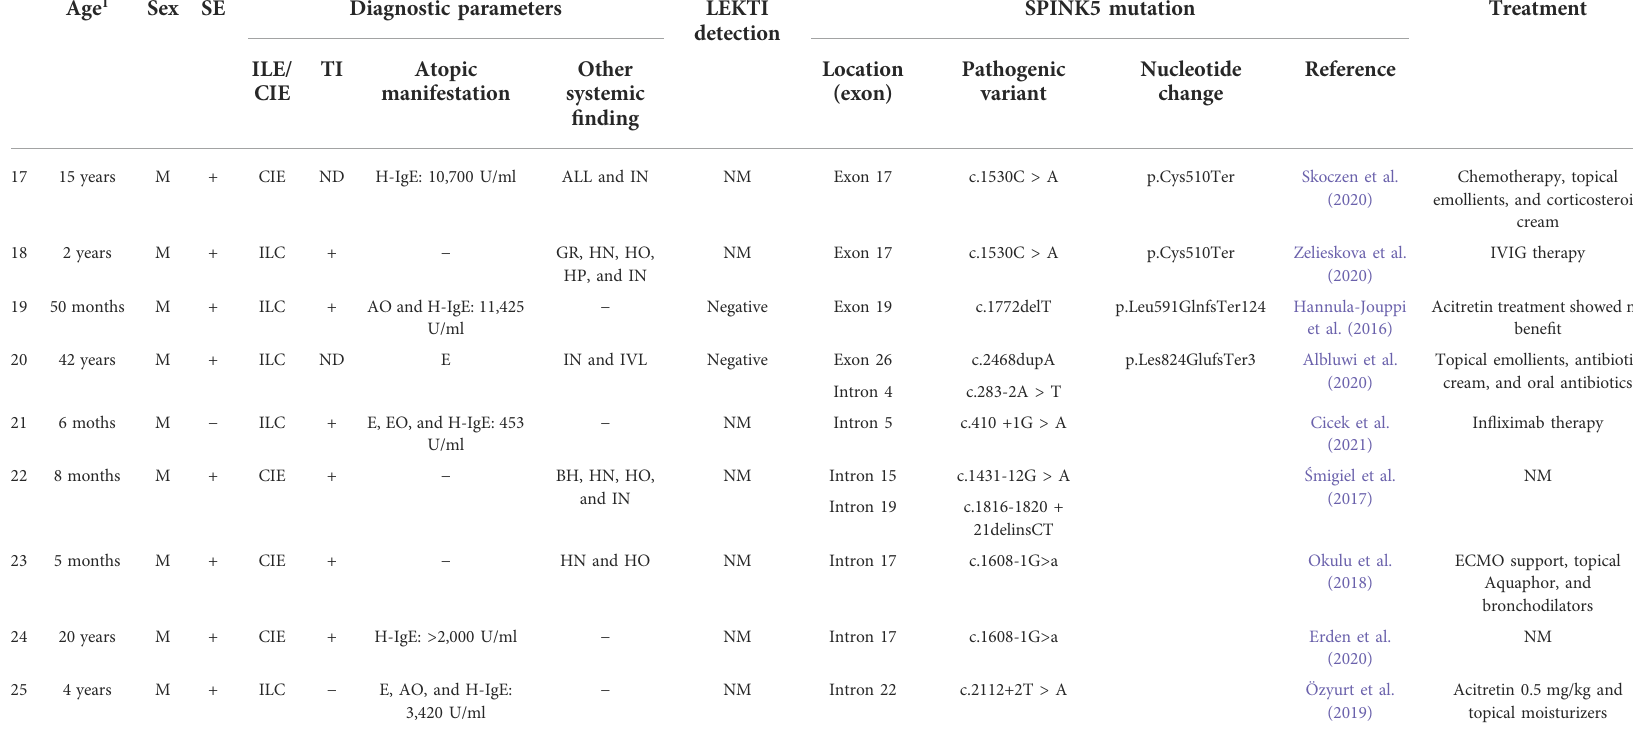
TABLE 1 ( Continued ) Summary of the clinical phenotype and genotype from patients with Netherton